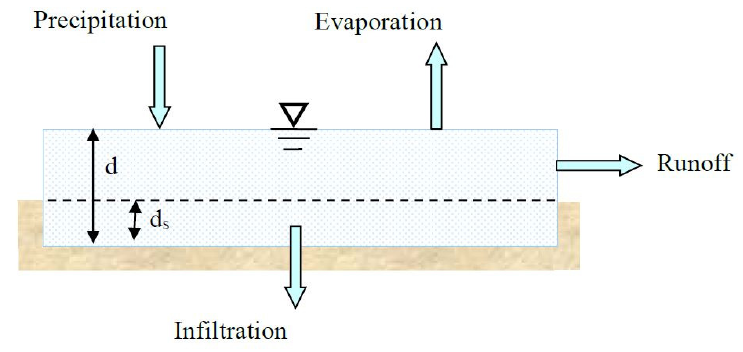
Figure 2. Nonlinear reservoir model of a sub-catchment [23].